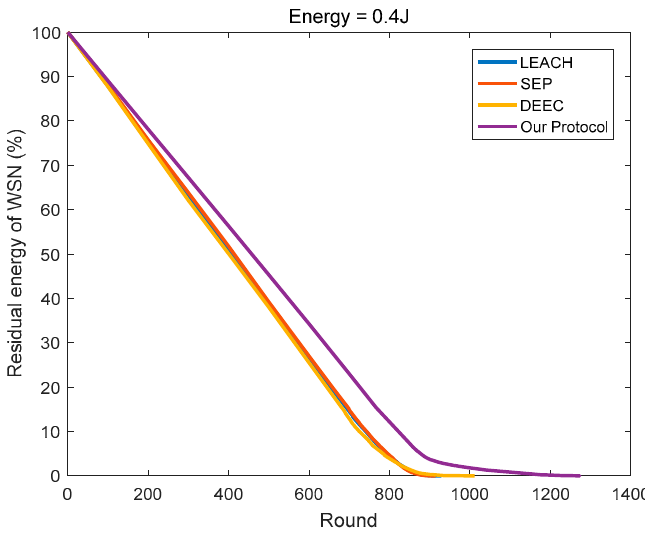
Sensors 2018 , 18 , x FOR PEER REVIEW Figure 17. The residual energy varies with the round (initial energy = 0.4 J). Figure 17. The residual energy varies with the round (initial energy = 0.4 J).